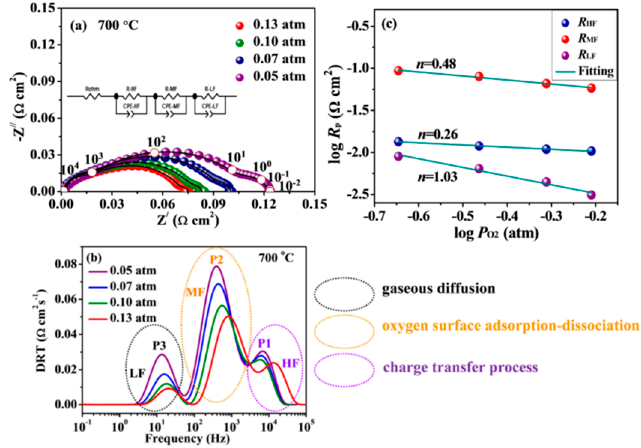
Figure 5. ( a ) Impedance spectra and ( b ) DRT results of BFY10 cathode under different oxygen partial pressure at 700 °C; ( c ) R H , R M , and R L of BFY10 cathode as a function at 700 °C.